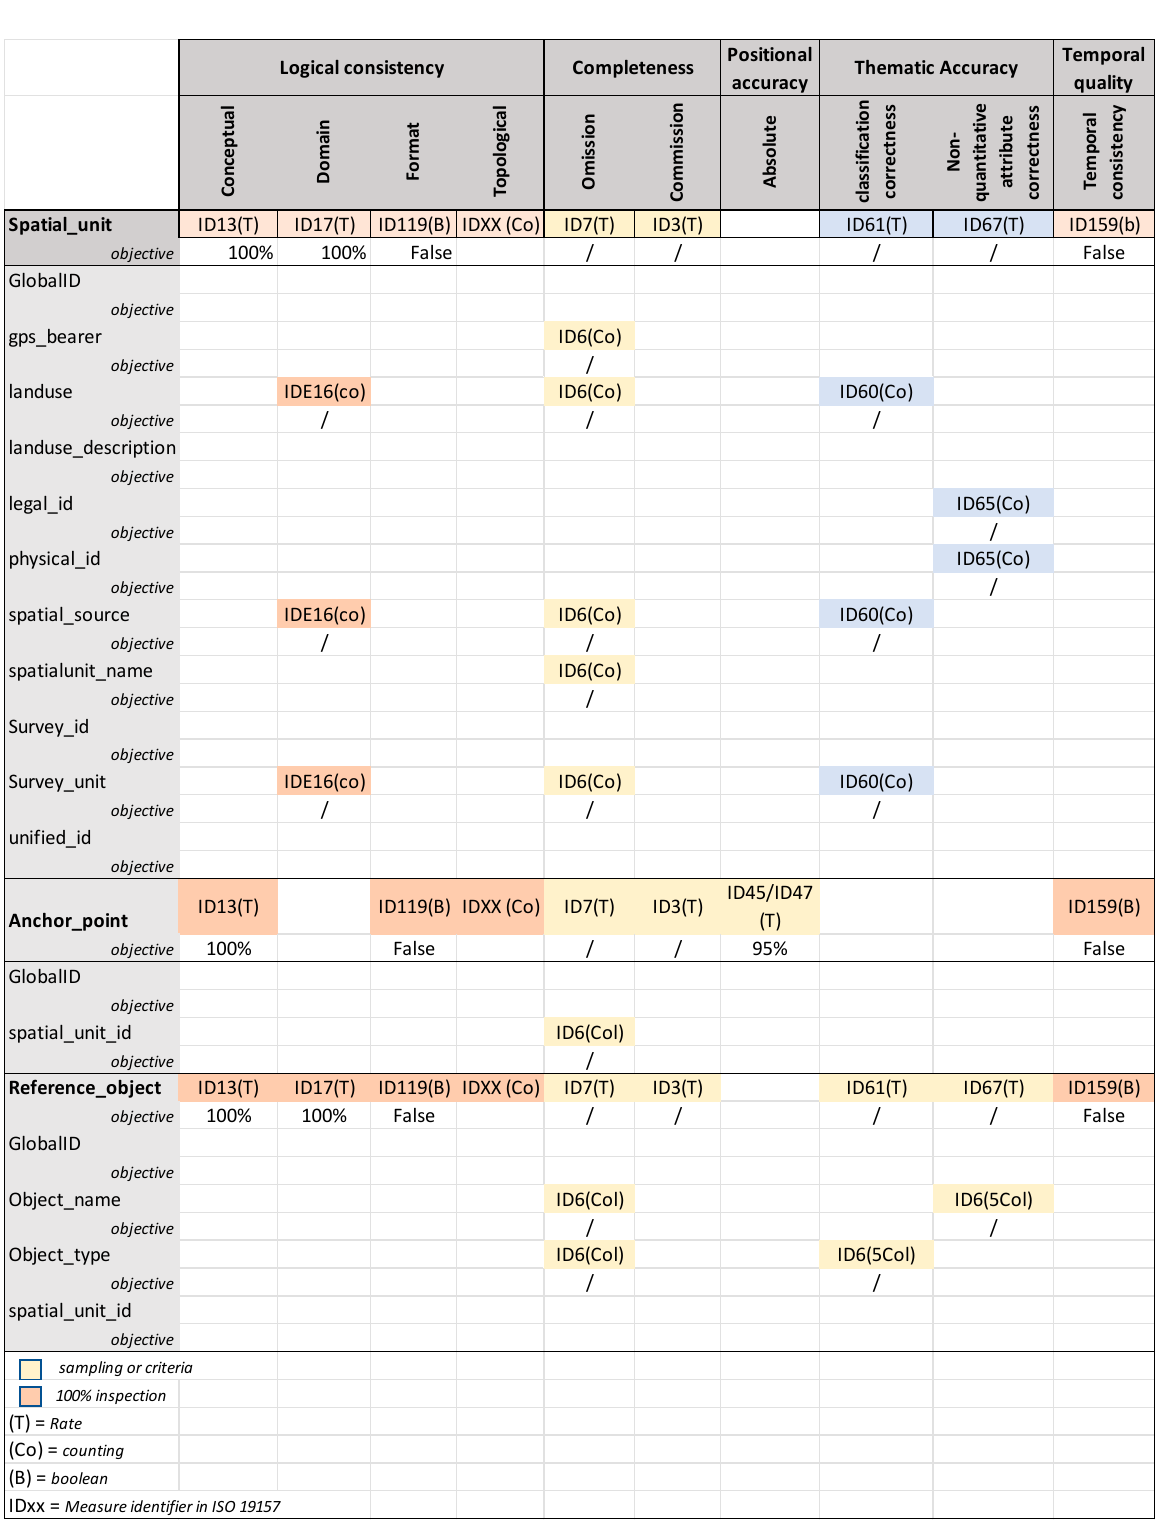
Figure 4. Quality scheme.